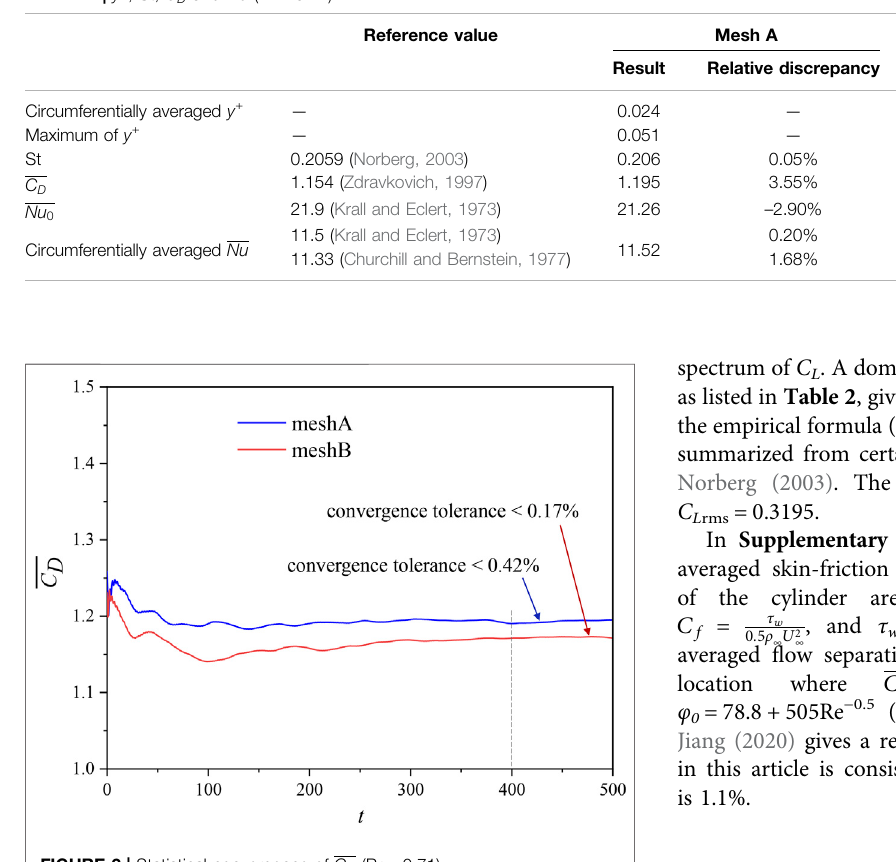
F L and F L is 0 . 5 ρ ∞ U 2 ∞ DL